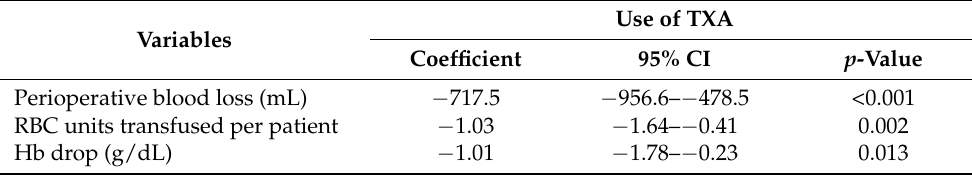
Table 3. Results of a multivariable regression analysis for the evaluation of the effect of TXA on blood loss parameters adjusted for age, gender, BMI, resection length and type of resection (proximal femur, distal femur, proximal